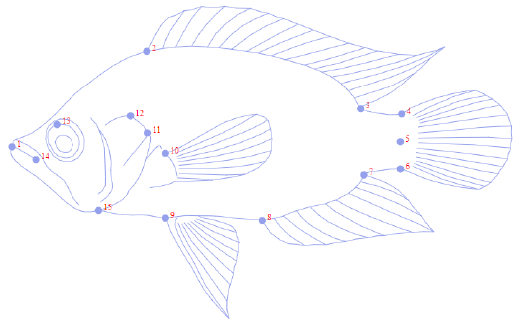
Figure 2. Graphical representation of Caquetaia kraussi body shape with 15 landmarks. Table 1. Anatomical description of landmarks in C. kraussii .